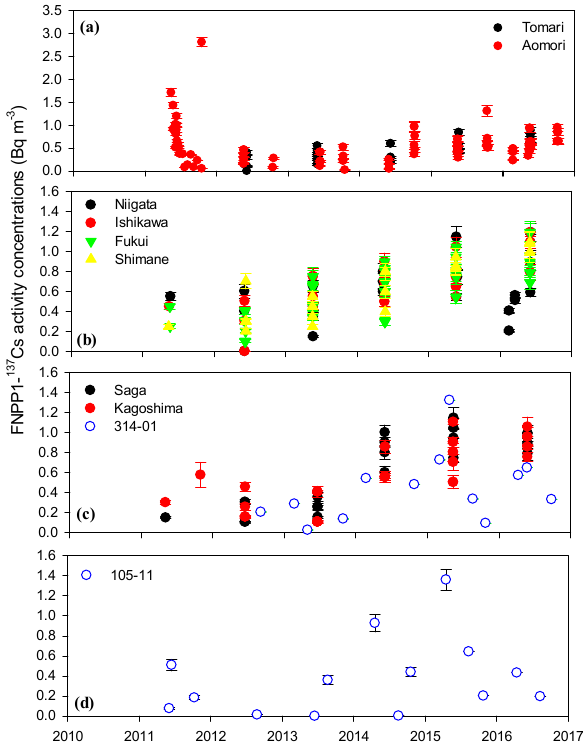
Figure 3. Temporal variations in the FNPP1-derived 137 Cs activ- ity concentrations in the surface seawater at the monitoring sites in Japan after 2011. FNPP1-derived 137 Cs: (a) Tomari, Aomori, (b) Niigata, Ishikawa, Fukui, Shimane, (c) Saga, Kagoshima, 314-01 and (d) 105-11.